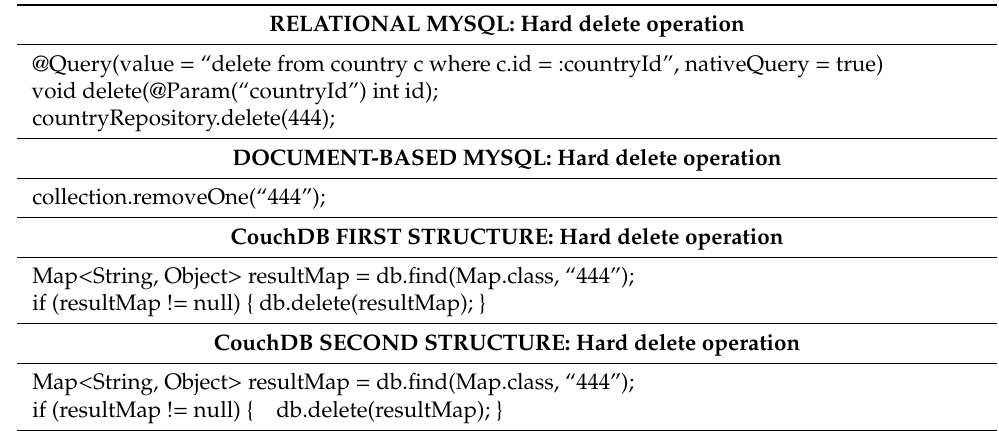
Table 10. Hard delete